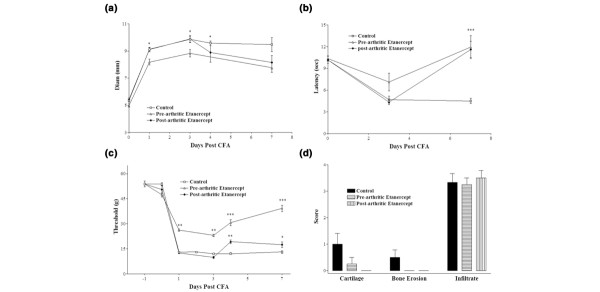
Etanercept treatment attenuates mechanical and thermal hyperalgesia, with little effect on swelling and histological damage. (a) Prearthritic etanercept treatment in rats with arthritis induced by complete Freund's adjuvant (CFA) reduced paw swelling significantly, by 10%, until 4 days after inflammation induction (n = 4). Thermal (b) and mechanical (c) hyperalgesia were assessed throughout the study. (b)Both prearthritic and postarthritic etanercept therapy abolished thermal hyperalgesia 7 days after inflammation (n = 4). (c) Prearthritic etanercept treatment reduced mechanical hyperalgesia significantly throughout the period studied, and postarthritic treatment reduced hyperalgesia to a lesser extent. (d) Joints were stained with haematoxylin and eosin and were assessed on a 4-point scale (where 0 = absent, 1 = mild, 2 = moderate, 3 = severe) for severity of inflammatory infiltrate, bone necrosis, and cartilage damage. CFA induced inflammatory infiltration 3 days (not shown) and 7 days (d) after CFA, while bone and cartilage were largely preserved. We found no reduction in histological score with either etanercept treatment regime. *P < 0.05; ***P < 0.005 in comparison with controls.